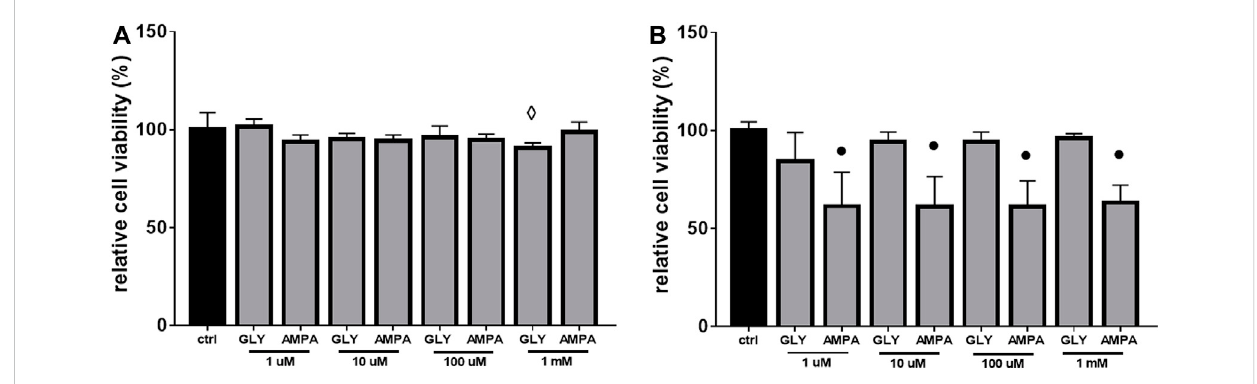
FIGURE 8 Cell viability. The fi gure shows the relative histograms obtained from MTT assays. H9c2 cells were treated with 1 μ M to 1 mM of glyphosate (GLY) or AMPA for (A) 24 h or (B) 48 h. Mean ± SD; p -values: ◇ < 0.005; C < 0.0001 vs .